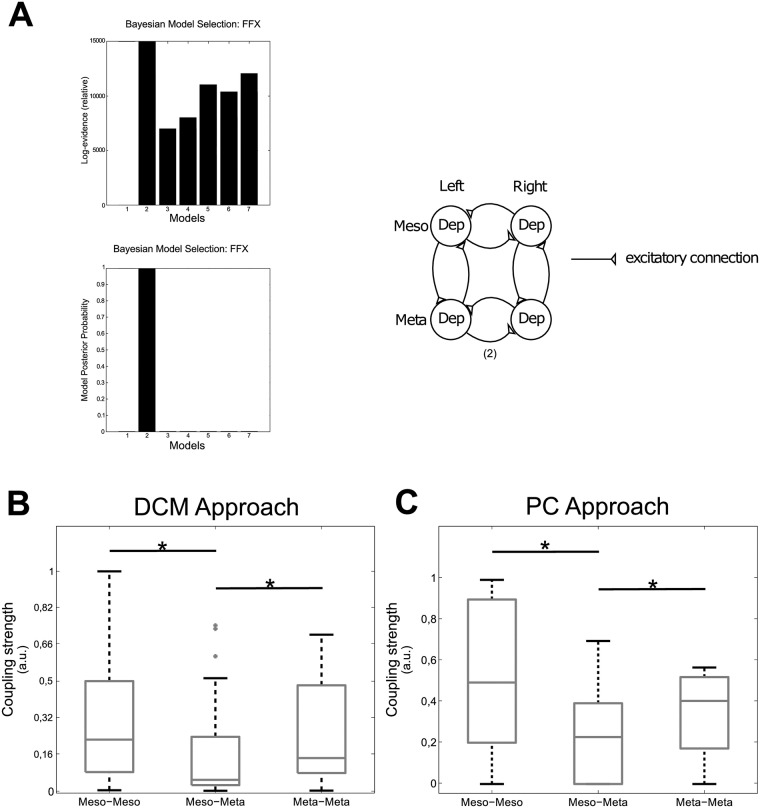
Connectivity meso-meta.A: BMS results for meso-meta DCM (left) and winning model structure (right). B: Boxplot showing the connectivity strengths for the DCM approach. The connectivity strengths were calculated for intervals that were pre-identified as phase-coupled by the PC approach. C: Boxplot showing the connectivity strengths for the PC approach. Meso-Meso denotes coupling between both sides of the mesothoracic and meta-meta the one between both sides of the metathoracic ganglion. Meso-Meta represents the intersegmental coupling between the meso- and the metathoracic ganglia. * denotes statistical significant differences.